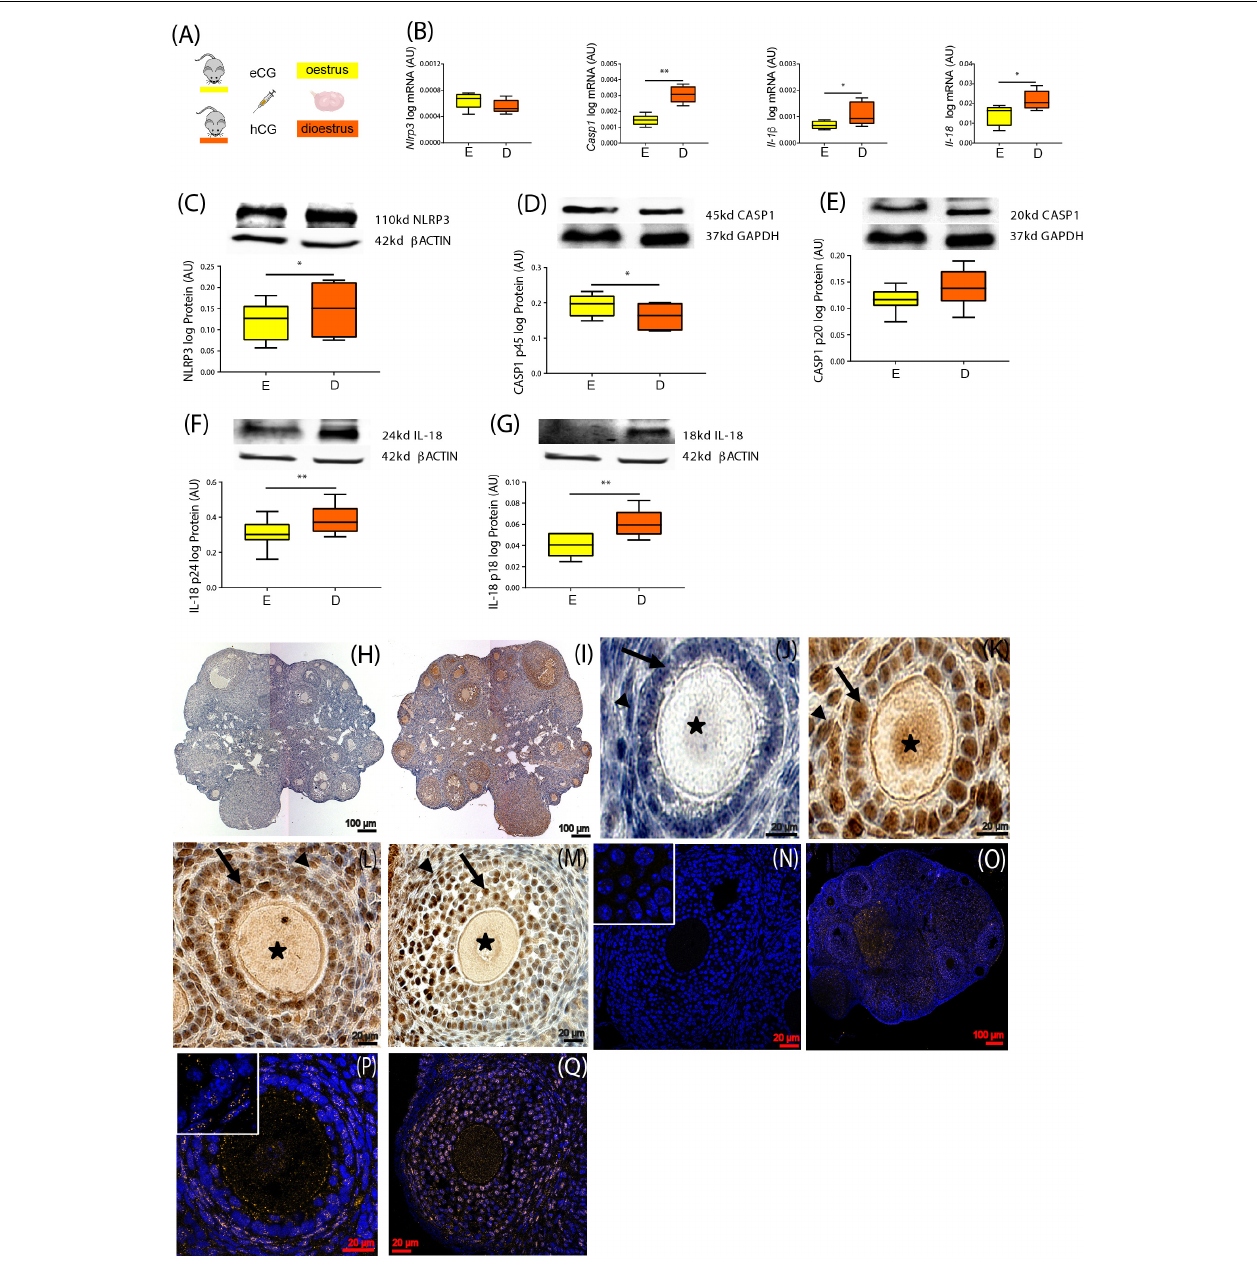
FIGURE 1 | Characterization of NOD-like receptor protein 3 (NLRP3) expression in the ovary of cyclic mice. (A) Experimental design: estrous cycle synchronization with equine chorionic gonadotropin (eCG) and human chorionic gonadotropin (hCG) as previously described (Hasegawa et al., 2016). Ovaries were collected from animals in the estrus (E) or diestrus (D) stage of the cycle. Quantification of mRNA levels of (B) Nlrp3 , caspase-1 ( Casp1 ), interleukin-1 β ( Il-1 β ), and interleukin-18 ( Il-18 ) by real-time PCR. Abundance of (C) NLRP3, (D) pro CASP1 p45, (E) CASP1 p20, (F) pro IL-18 p24, and (G) IL-18 p18 protein during (E,D) measured by Western blotting analysis. Data were normalized to ribosomal protein L37 ( Rpl37 ) mRNA expression and β -actin of or glyceraldehyde 3-phosphate dehydrogenase (GAPDH) protein expression. Bars represent mean ± SEM. Statistical analysis between groups was carried out using Mann–Whitney. Number of samples: n = 6–7 for real-time PCR analysis and n = 7–8 immunoblots. Asterisks indicate significant differences ( ∗ p < 0.05; ∗∗ p < 0.01). Representative immunohistochemistry (IHC) staining ( n = 2–3) of NLRP3 protein during follicular development in the mouse ovary. Positive staining in brown, counterstaining with hematoxylin. (H,J) Negative control incubated with secondary antibody. Localization of NLRP3 in (I) whole ovary of 16 weeks (wk) mice fed chow diet (CD), (K) primary follicles of 16- week CD mice, (L) secondary follicles of 16- week high-fat diet (HFD) mice, and (M) preantral follicles of 16- week CD mice. Staining was detected in granulosa (GC) and theca cells (TC). Faint staining was observed in the oocytes of all stages of folliculogenesis. Arrows denote GC, arrowheads denote TC, and asterisks denote oocytes. The IHC staining was confirmed by immunofluorescent localization of NLRP3. Positive staining in orange, nuclear counterstaining with DAPI in blue. (N) Negative control 16- week CD stained with polyclonal rabbit IgG. NLRP3 localized in (O) whole ovary, (P) secondary follicles of 16- week CD mice, (Q) preantral follicles of 16- week HFD mice. Inserts on the top left corners represent magnifications of GC. Scale bars represent 20 or 100 µ m. AU, arbitrary units.